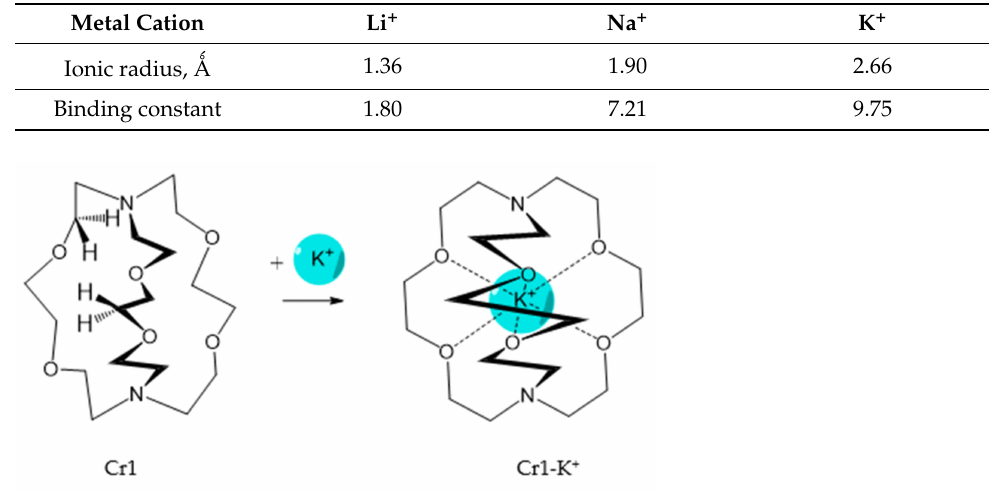
Figure 23. Conformational changes in cryptand-[2,2,2] during the formation of a complex with a potassium cation.